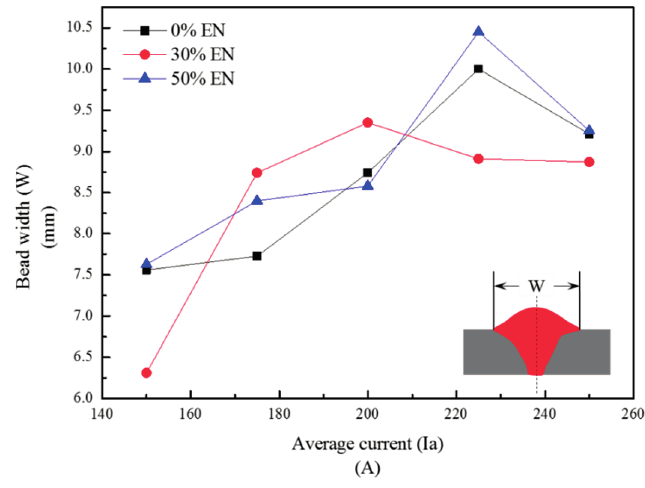
Figure 8. Comparison of bead width ( W ) at different EN ratio and Ia.